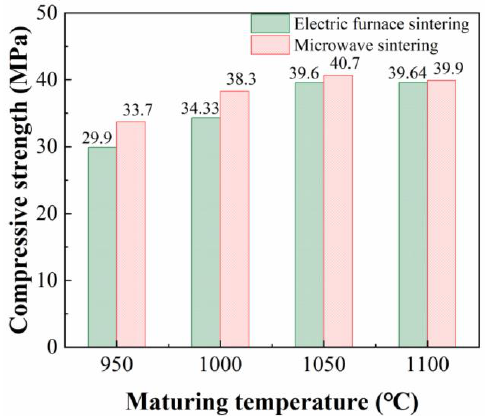
Figure 8. Influence of sintering temperature on compressive strength of MGS sintered brick.